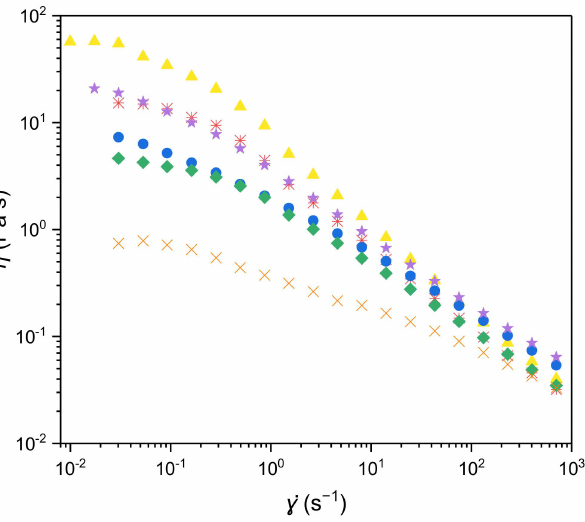
Figure 1. Apparent viscosity ( η ) as a function of shear rate ɣ̇ for the filmogenic solutions prepared with EPS A ( ), B ( ), C ( ), D ( ), E ( ), and F ( ), produced by Alteromonas strains isolated from French Polynesia (1.5 wt.% EPS, 30 wt.% glycerol for all solutions, except EPS A that was pre- pared with 60 wt.% glycerol).